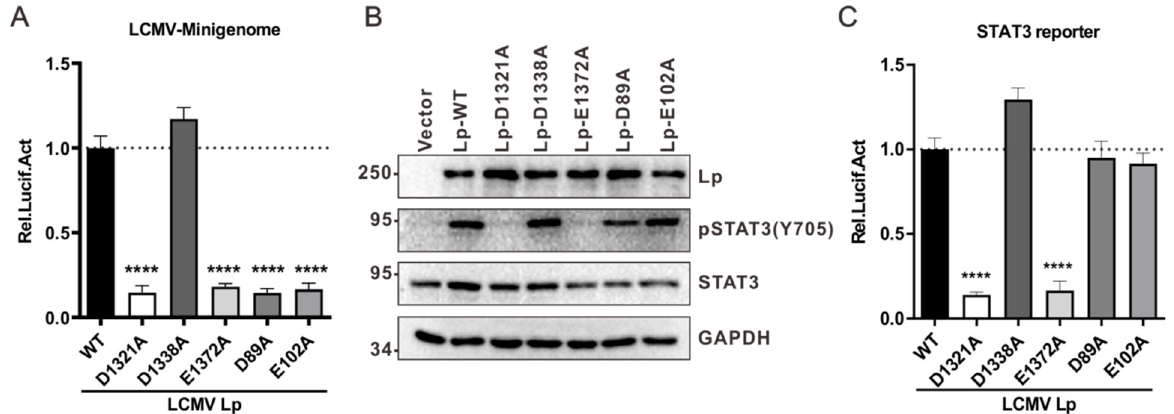
Figure 4. The activation of the STAT3 signaling pathway by Lp is associated with its RdRp activity. ( A ) Site mutations on LCMV Lp affect its mini-genome activity. BSR-T7 cells in a well of a 24-well plate were co-transfected with 50 ng pRL-TK, 300 ng pVSV-LCMV-S- ∆ GPC/Fluc, 300 ng pCAGGs-LCMV-NP, and 600 ng of the indicated pCAGGs-LCMV-Lp plasmids. At 48 h post transfection, cells were lysed and subjected to luciferase assay to measure their mini-genome activity. ( B , C ) The activation of STAT3 is associated with the RNA-dependent RNA polymerase activity, but not the endonuclease activity of LCMV Lp. ( B ) HEK 293T cells in a well of a 24-well plate were transfected with 500 ng of the indicated pCAGGs-LCMV-Lp plasmids. At 36 h post transfection, cells were lysed and subjected to Western blot analysis. ( C ) HEK 293T cells were transfected with the indicated pCAGGs-LCMV-Lp and STAT3 reporter plasmids. At 36 h post transfection, cells were lysed and subjected to a luciferase assay to measure the STAT3 reporter activity. A representative from at least three independent experiments is shown. Graphs show mean ± SD. ( n = 3, A , C ). **** p < 0.0001, unpaired Student’s t -test.